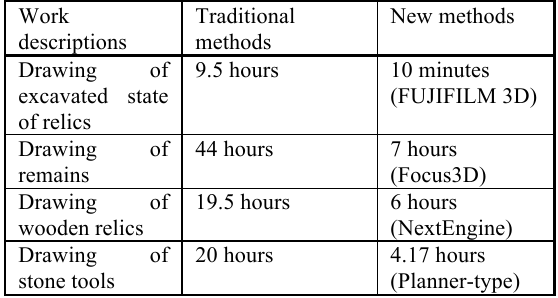
Table 2. Working Time at Side